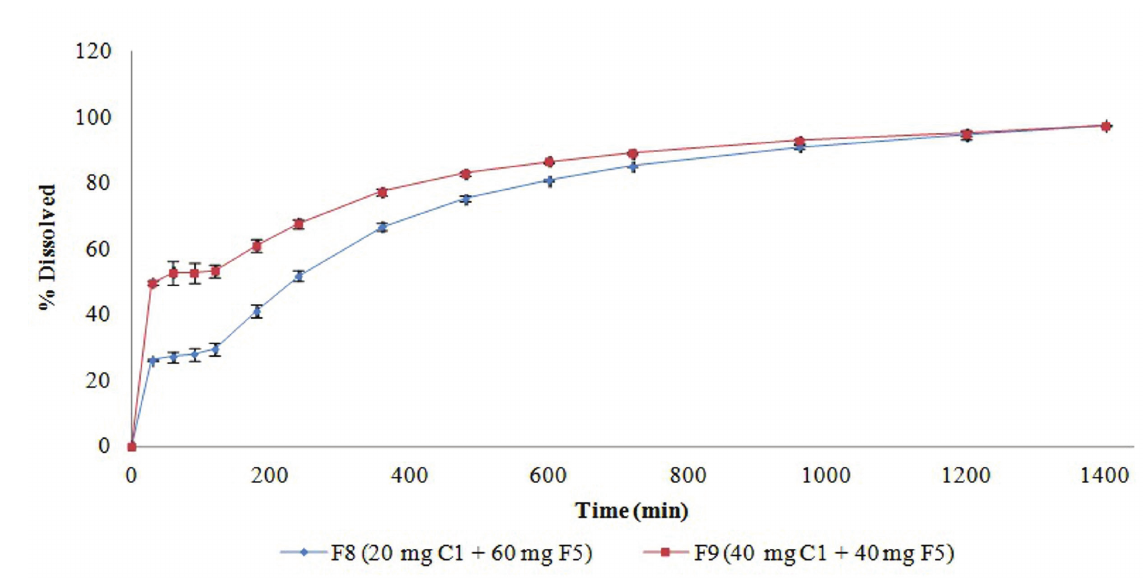
FIGURE 5 - F8 and F9 biphasic release profiles. TABLE VI - Factorial experimental design 2 2 for the variables HPMC (mg) and EC (mg) with triplicate at the center point and release response time 100% (min) for the release profile of the pellets of modified release PROP